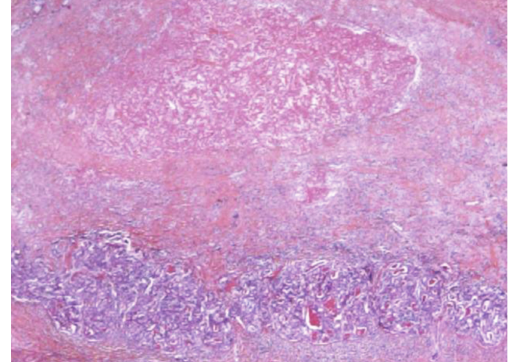
Figure 3: Microscopic examination of patient 1’s specimen at ∗ 10 magnification after hemalun eosin safran coloration. Bottom of the figure shows the HCC with a pseudoglandular aspect; top shows an eosinophilic irregular area corresponding to